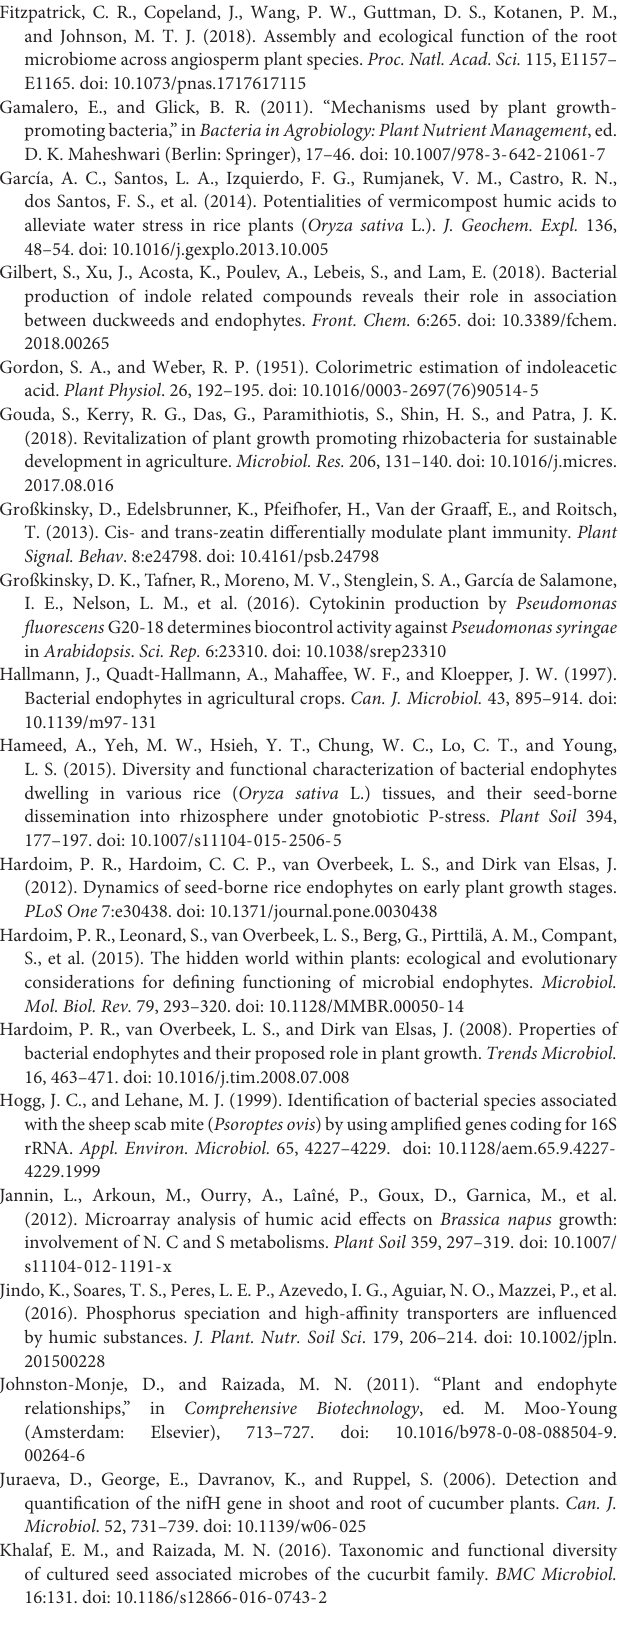
Frontiers in Plant Science |